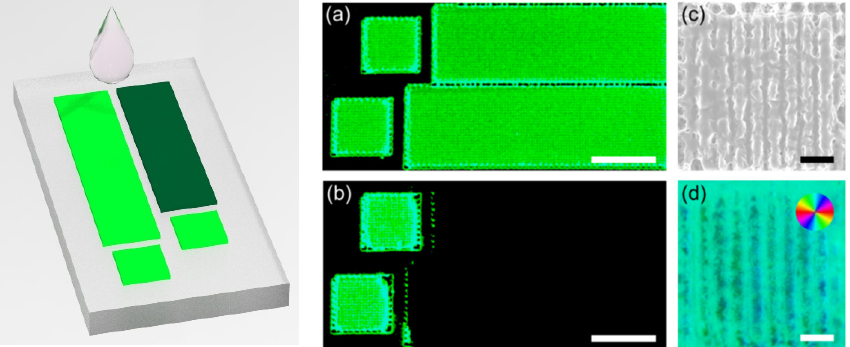
Figure 5. Hydrophilic surface laser patterning. Fluorescence images of the hydrophilic patterns ( a ) before and ( b ) after dropping the Co 2+ aqueous solution (0.1 mol/L) at the far right of the patterns. The gaps between the left squares and the right rectangles are 100 µm. The scale bars are 500 µm. ( c ) Corresponding SEM and ( d ) birefringent slow axis orientation images of the laser-patterned PVA surface. Pseudo colors (inset ( d )) indicate the direction of the slow axis. The scale bars are 10 µm. Laser parameters: 300 mW, 10 mm/s scanning speed, 1 MHz repetition rate, 0.25 NA objective lens.